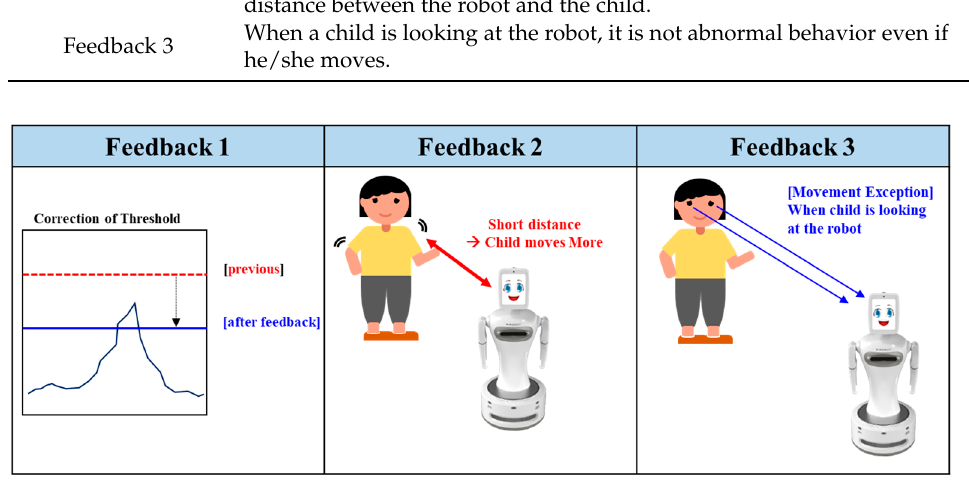
Figure 13. Feedback on the video-labeling review.